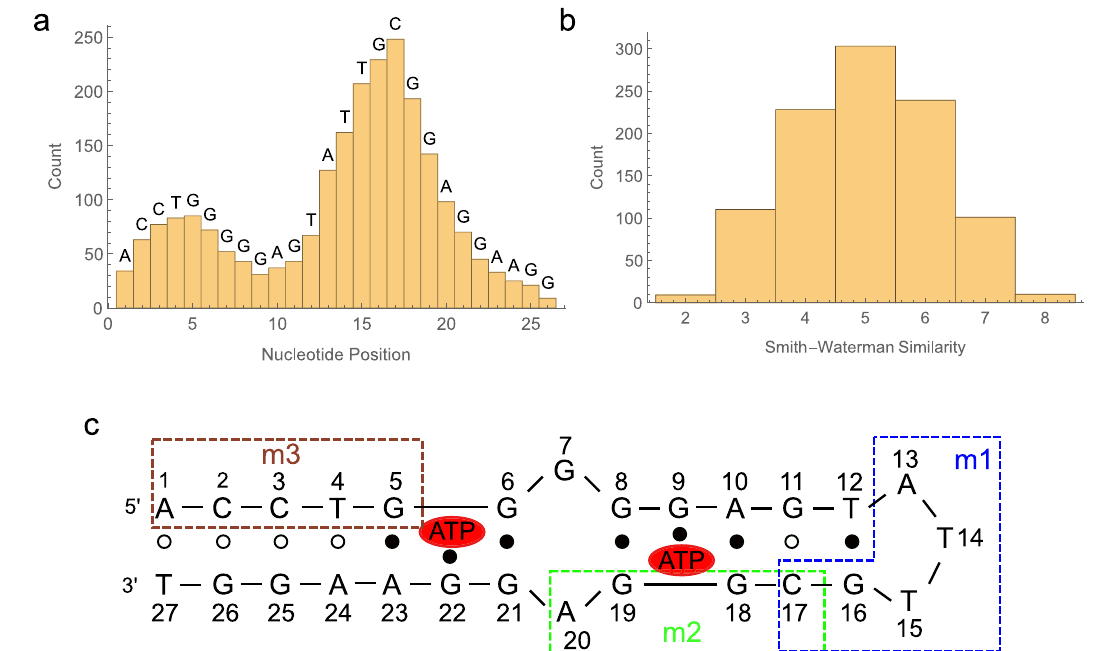
Fig.2|Analysisofthe1000best-performingADSsequences.a Histogramofthe frequency with which each base-position within the ATP aptamer was com- plementary to an SD sequence. This analysis was based only on the longest com- plementary region for each SD, with complementary regions of <3 nucleotides discarded. Nucleotides at each position in the aptamer are labeled above the his- togram. Source data are provided as a Source Data fi le. b Histogram of Smith-